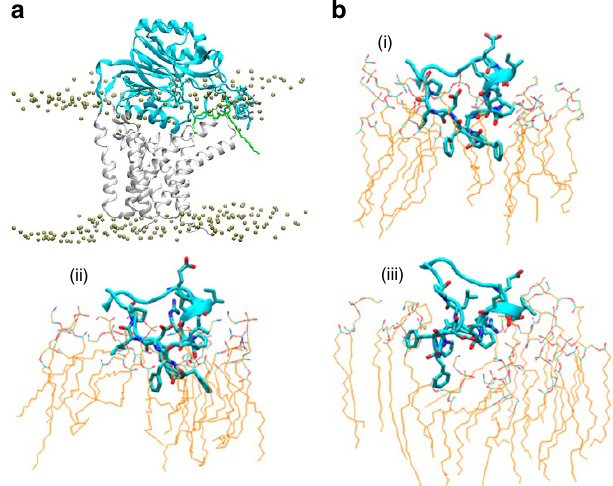
Figure 5 | Snapshot of the last step of simulation 1. In this simulation (Sim 1), the lid loop is embedded into the lipid membrane. ( a ) Overall conformations of Lnt and surrounding lipid molecules. The Nit and TM domains are shown as cyan and grey cartoon model, respectively, and the lid loop region is shown in cyan stick model. For the lipid bilayer, only the phospho-atoms from the lipid molecules are shown as spheres, except for one lipid molecule inside the cavity, which is shown as green stick model. ( b ) More detailed interactions between lid loop residues (thick stick models) and surrounding lipid molecules (thin line models) for three snapshots. (i) The initial energy-minimized model; (ii) a snapshot after 20ns simulations with Lnt constrained; (iii) a snapshot after 150-ns free dynamics simulations. (Also see a Supplementary Movie